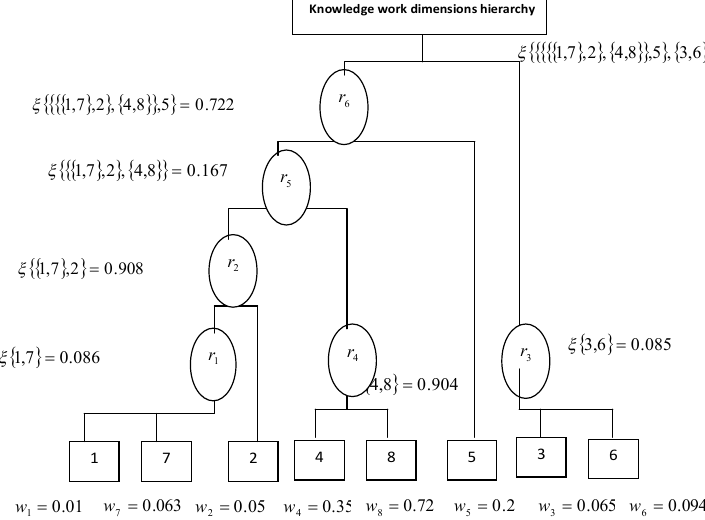
Fig. 6. Identified hierarchy diagram